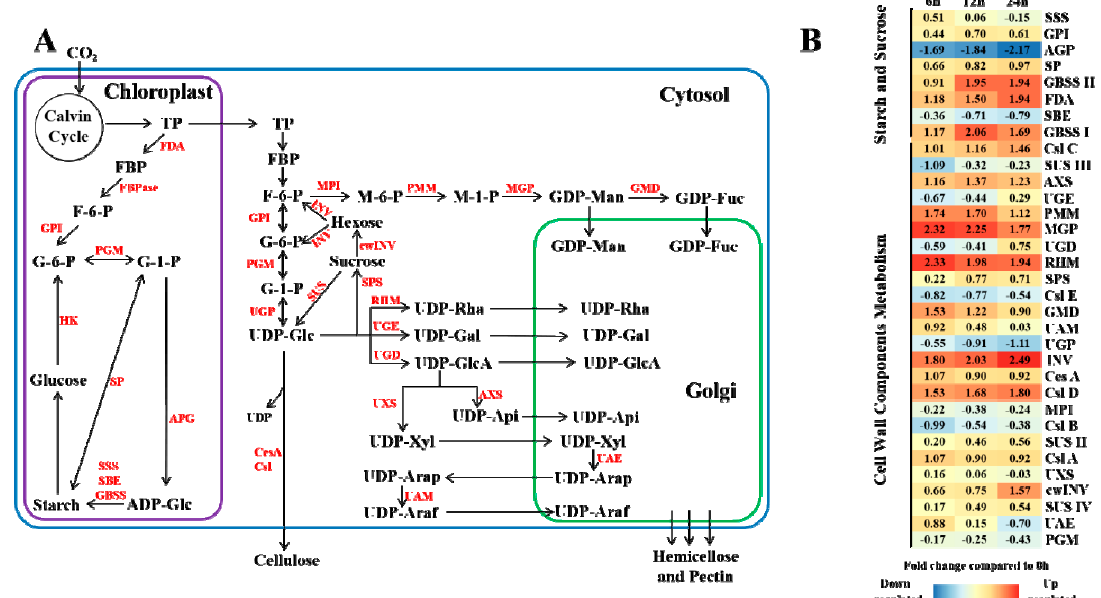
Figure 3. Influence of high CO 2 concentration on sucrose, starch and cell wall components. ( A ) The sucrose, starch and cell wall component biosynthesis pathways according to Evžen [28] and Jana [29]. The blue, purple and green rectangles represent the cytosol, chloroplast and Golgi, respectively. The di ff erent enzymes are shown in red font. ( B ) Expression changes in the genes involved in metabolic pathways in response to stress. White indicates no change, red up-regulation, and blue down-regulation in each treatment, as shown in the color bar for a log 2 fold change scale. The abbreviations in the figure are shown in Table A2 from Appendix